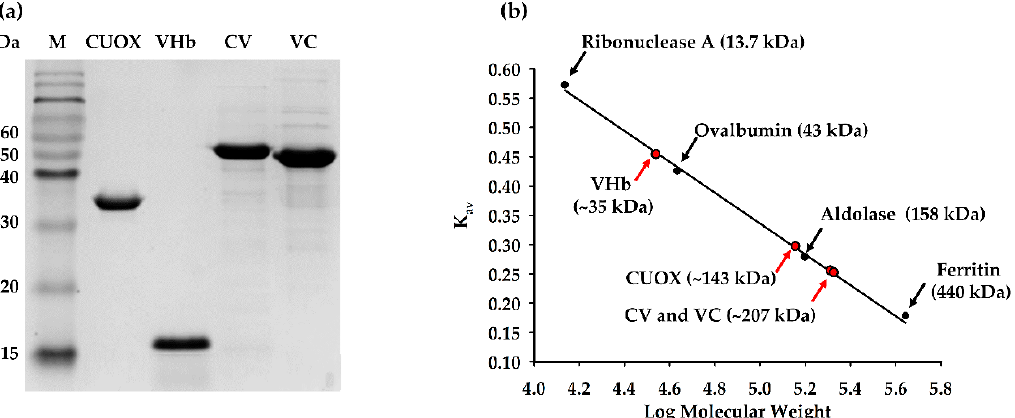
Figure 2. ( a ) SDS-PAGE analysis showing purity after protein purifications and molecular weight the denaturing condition of native and fusion proteins. Lane 1, protein molecular weight marker; lane 2, purified CUOX; lane 3, purified VHb; lane 4, purified CUOX-VHb fusion protein; and lane 5, purified VHb-CUOX fusion protein. ( b ) The gel-filtration chromatography calibration curve was performed according to the manufacturer’s protocol (GE Healthcare Life Sciences, PA, USA). The linear curve representing K av values versus molecular weights of the standard proteins including ribonuclease A, ovalbumin, aldolase and ferritin. K av of CUOX, VHb and fusion proteins are shown in red circles.